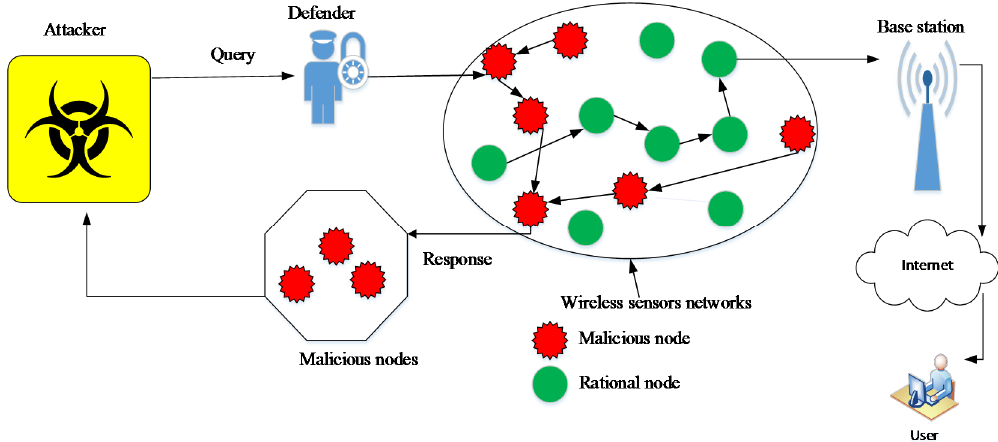
Figure 2. The architecture for half of the rational nodes choosing defense.